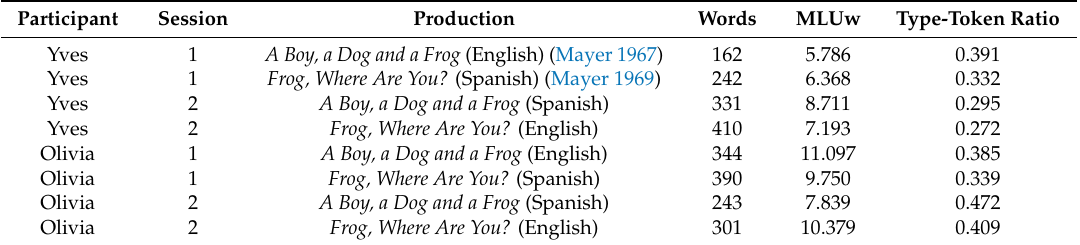
Table 3. Length, mean length of utterances by words (MLUw), and Type-token ratio values for each participant and